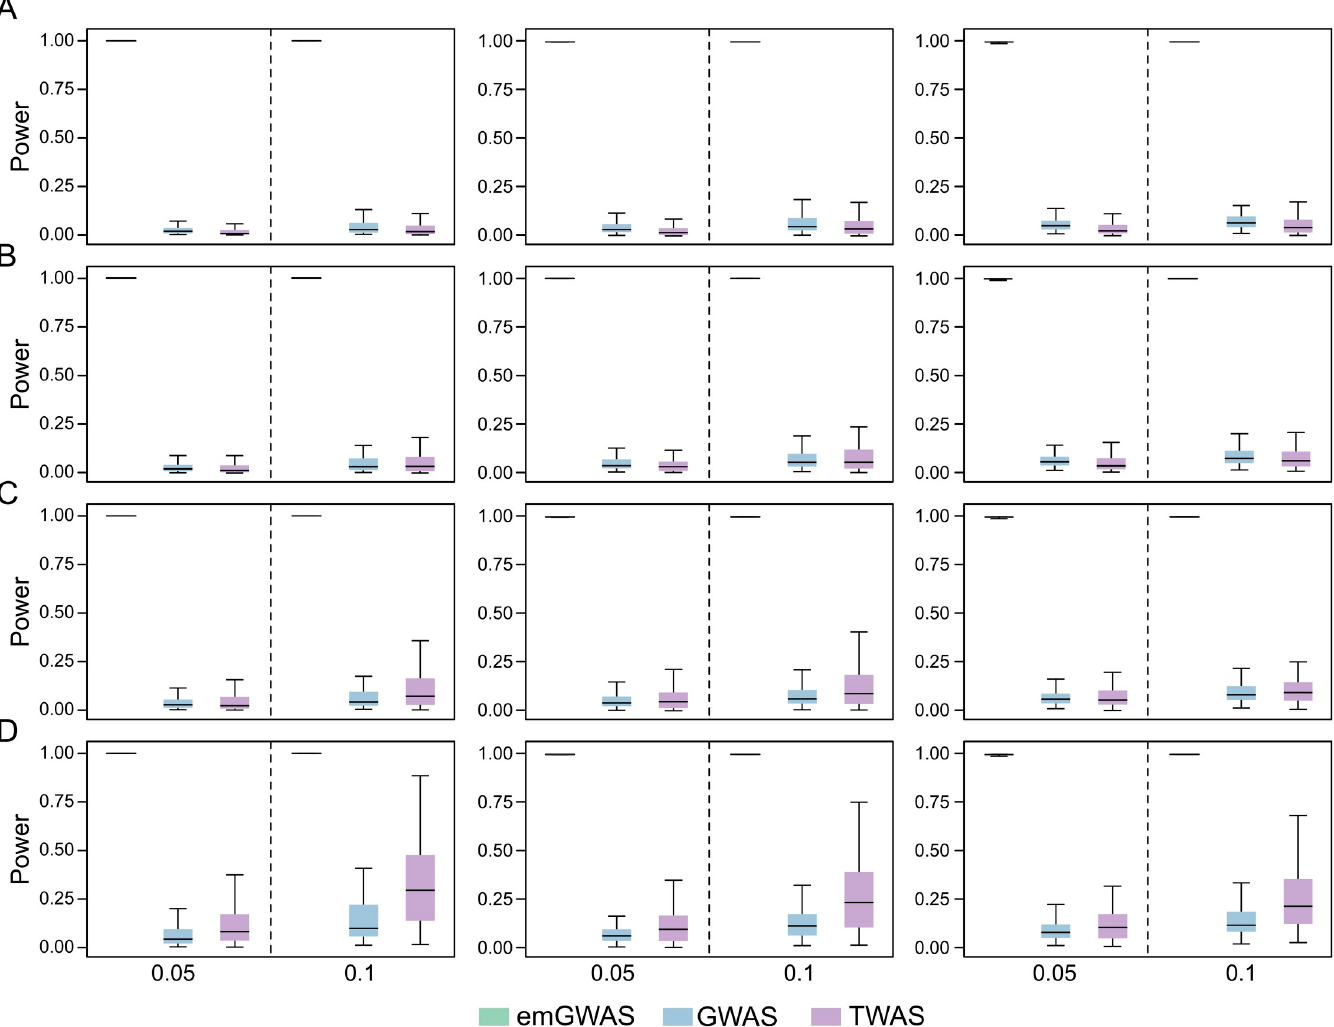
Fig 3. Causality scenario when expression heritability is low and PVX is high. The PVX is 0.05 and 0.1 in the two columns as indicated by the X-axis labels. The numbers of genes contributing to phenotype in the left, middle and right panels are 4, 9, and 13 respectively. The expression heritability levels in (A), (B), (C) and (D) are 0.025, 0.03, 0.04, and 0.08 respectively. The number of causal variants per gene is randomly sampled from the interval [4,9].